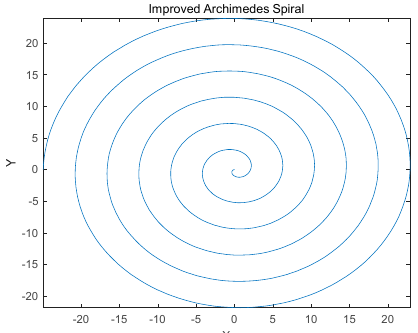
Figure 1. Improved Archimedes’ spiral.